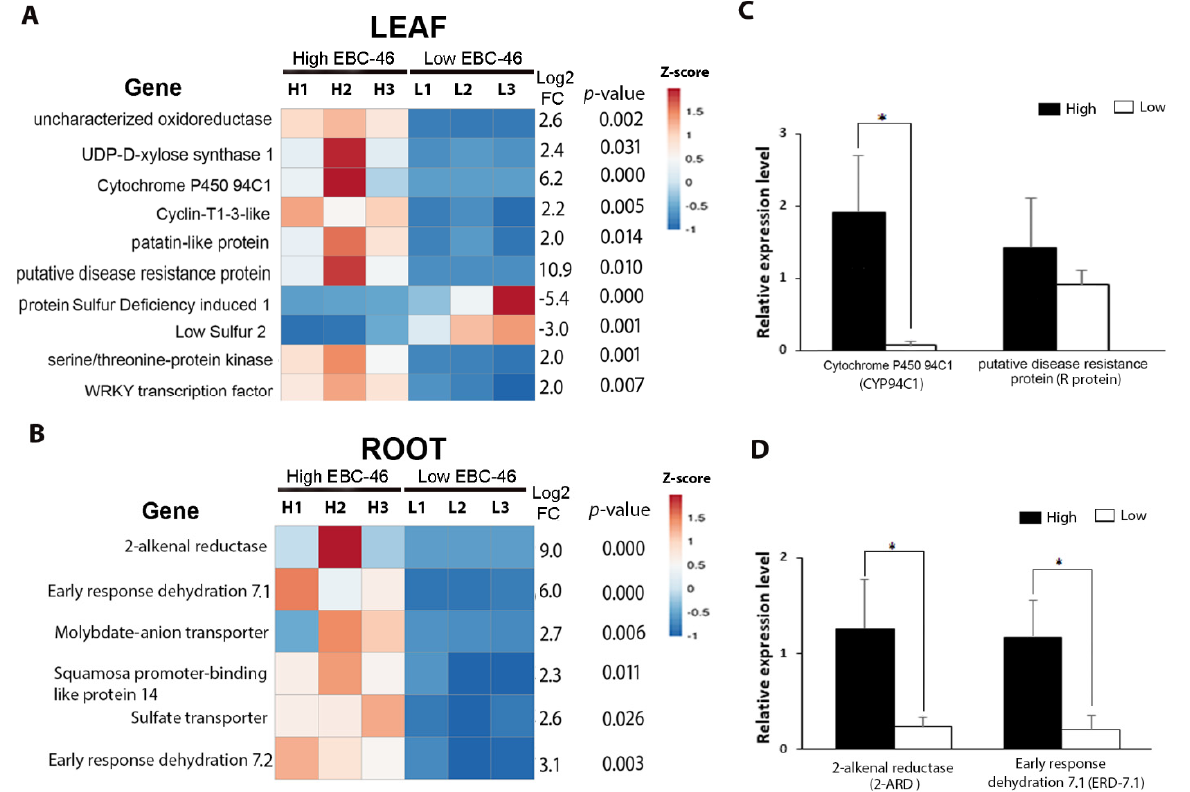
Figure 3. Validation of differentially expressed genes. Heatmaps showing RNA-seq relative gene expression, log2 fold-change, and p -value for H EBC-46 and L EBC-46 F. picrosperma in ( A ) leaf tissue and ( B ) root tissue . Four genes were further analysed by RT-qPCR in ( C ) leaf tissue and ( D ) root tissue. * represents statistically significant differences ( p < 0.05).